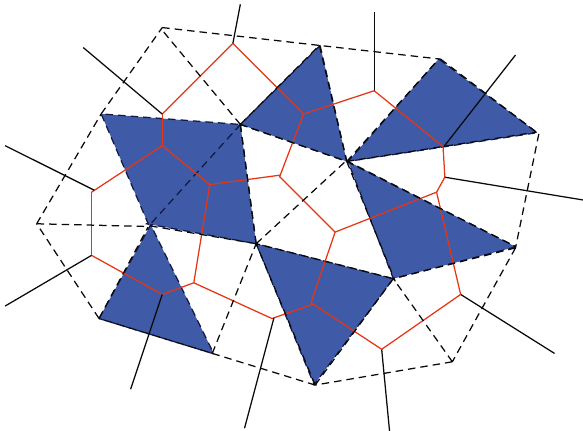
Figure 6: Dirichlet domain segmentation (solid line) and Delaunay triangulation (dashed line).